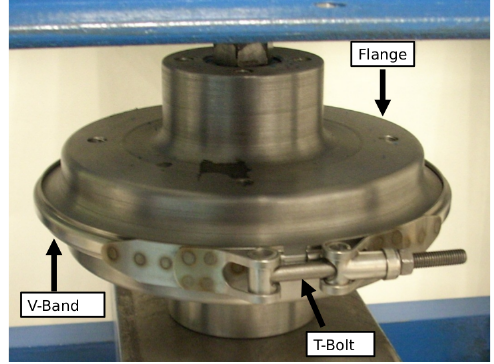
Figure 1: V-band retainer assembled to a pair of test